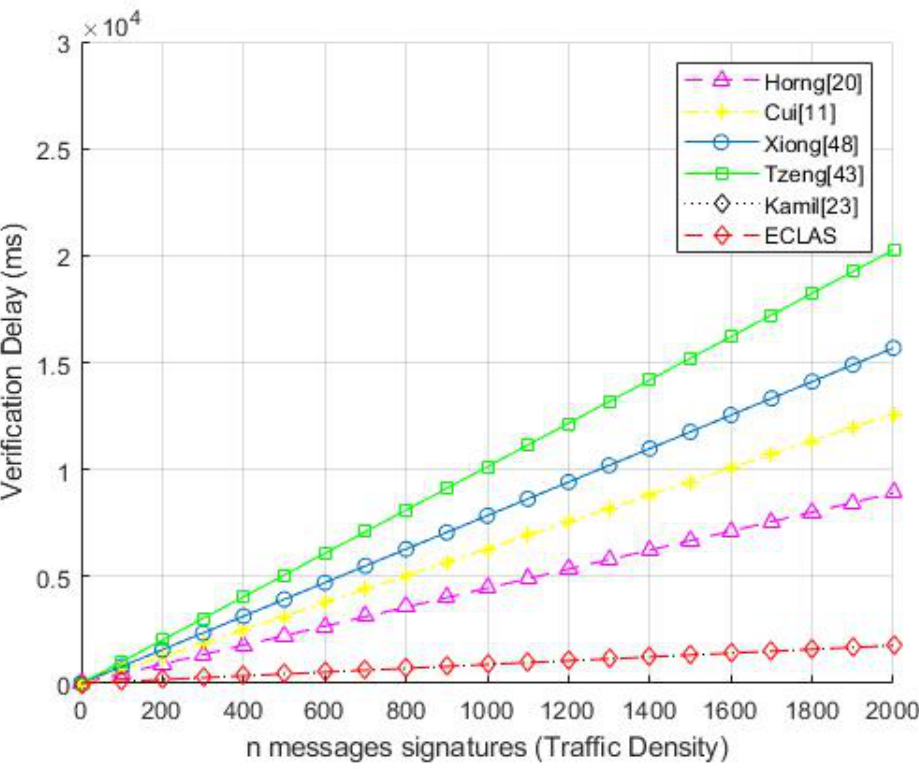
Figure 3. Verification Time Delays and Number of Signatures